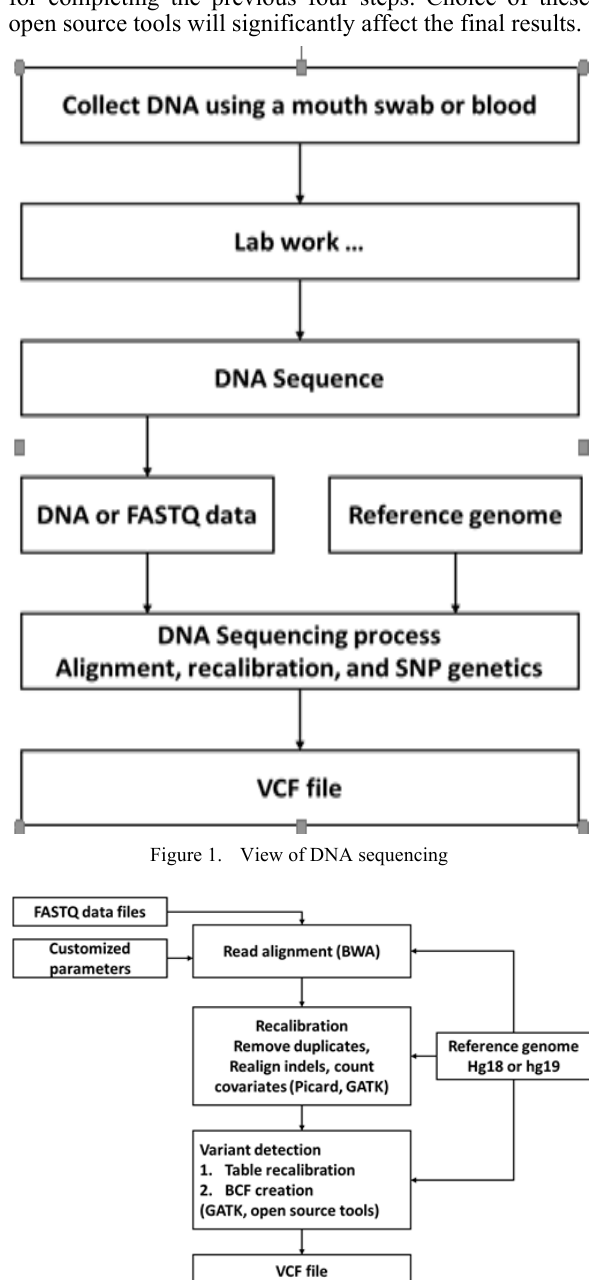
Figure 2. DNA sequencing